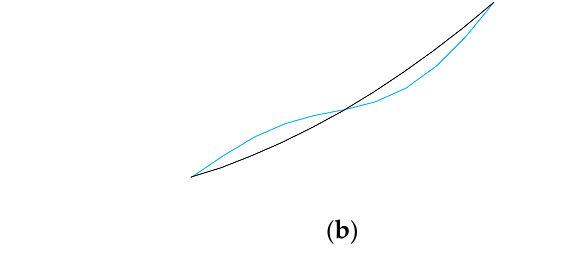
Figure 6. Vibration modes and frequencies of single conductor. ( a ) First symmetric lateral bending (f = 0.080 Hz), ( b ) Second asymmetric vertical bending (f = 0.160 Hz).